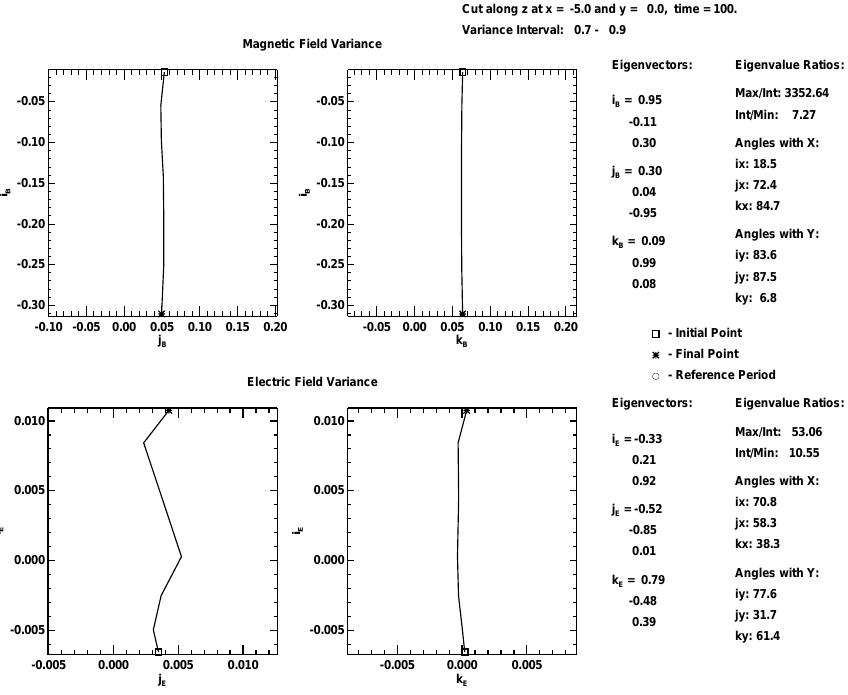
Fig. 7. Results of the boundary normal calculation for the traversal of the CDC/magnetosheath boundary at (x,y) = ( − 5 , 0 ) under northward IMF